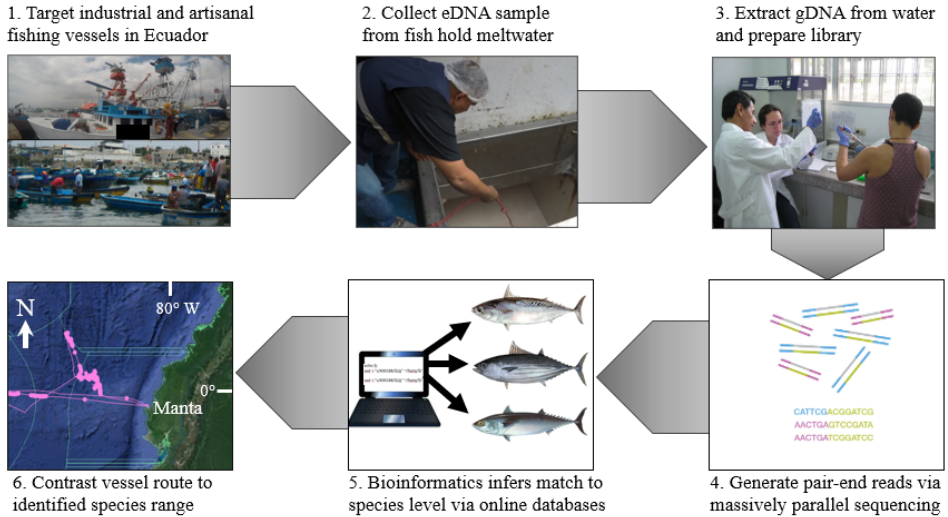
Figure 1. Schematic overview of experimental design using eDNA metabarcoding to characterize fish catch from industrial and artisanal fishing vessels in Ecuador.